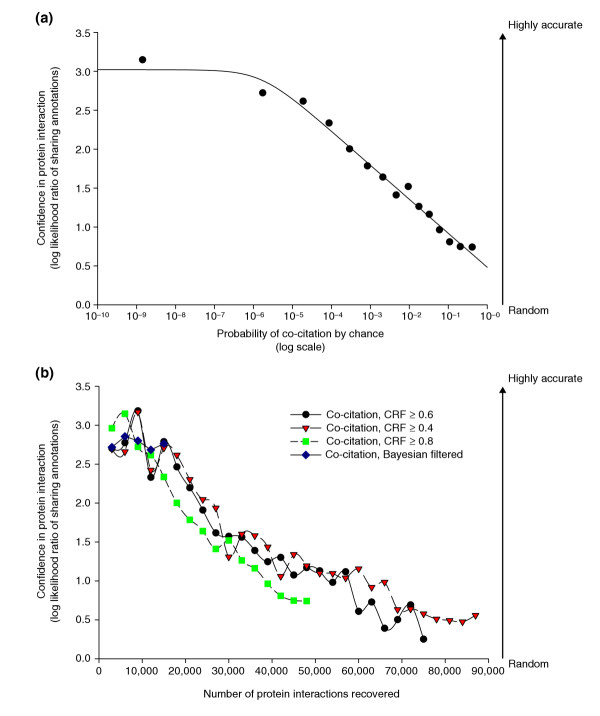
The performance of the co-citation algorithm at identifying protein interactions. (a) The probabilistic score effectively ranks co-cited proteins by their tendency to participate in the same pathway, as measured on the functional annotation training benchmark. As the probability of random co-citation decreases, the functional relatedness of the co-cited proteins increases. This tendency is robust to changes in the CRF confidence threshold chosen (data not shown). Each point represents 3,000 protein pairs. (b) An examination of the number of protein pairs identified at different CRF thresholds (0.8, 0.6, and 0.4) shows that the recall of the method is increased with lowered thresholds. Re-ranking the 15,000 top-scoring protein pairs (CRF threshold = 0.8) by the tendency of the abstracts to discuss physical protein interactions shows their consistent performance in the annotation benchmark.